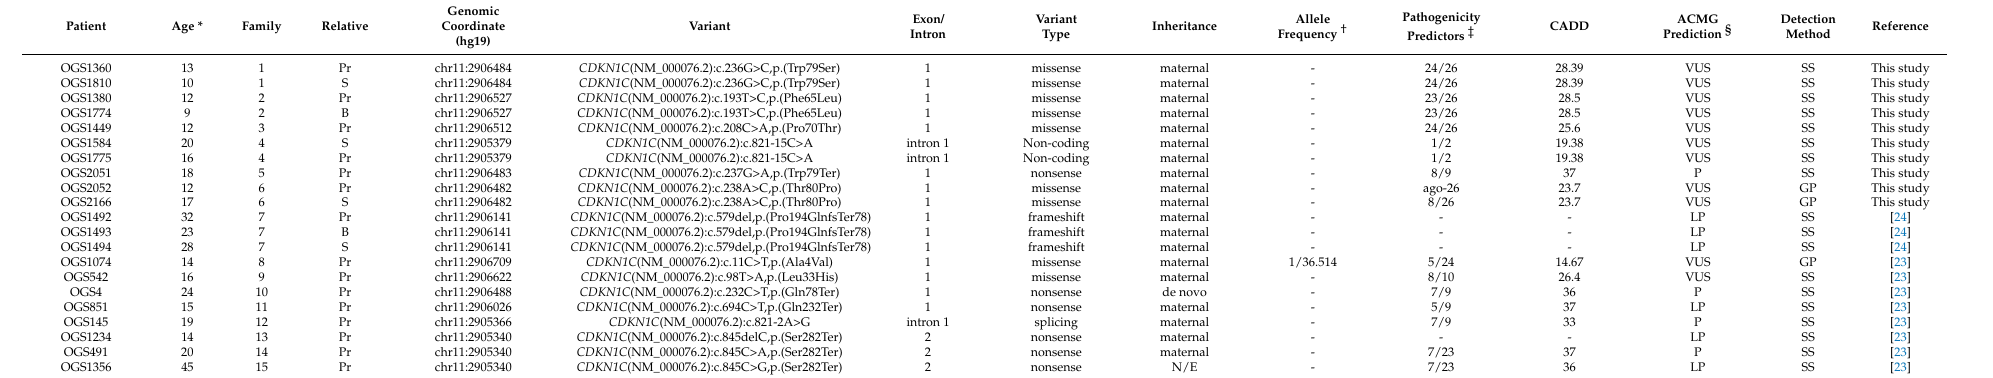
Table 1. Variants detected in CDKN1C